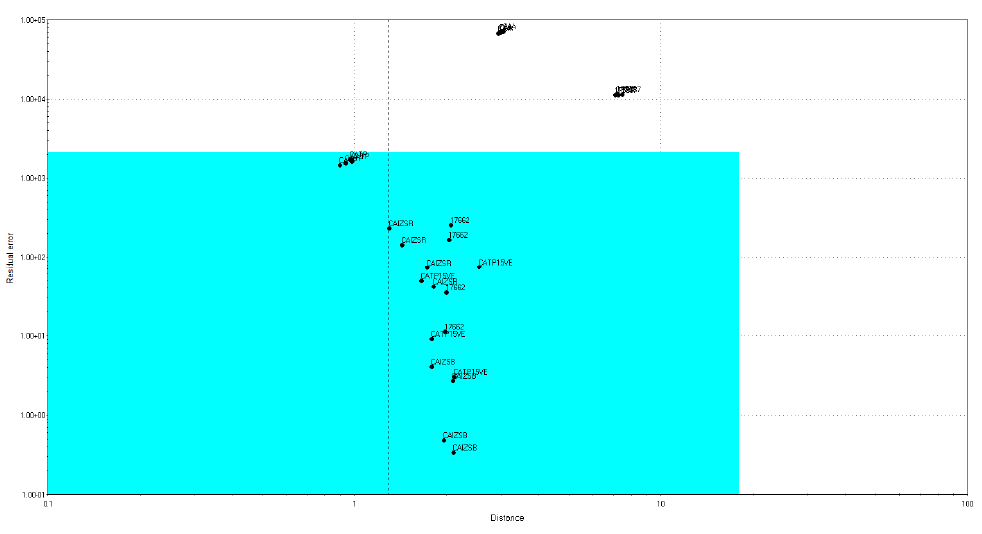
Figure 3. Soft Independent Modeling Class Analogy (SIMCA) model for Chestnut honeys.